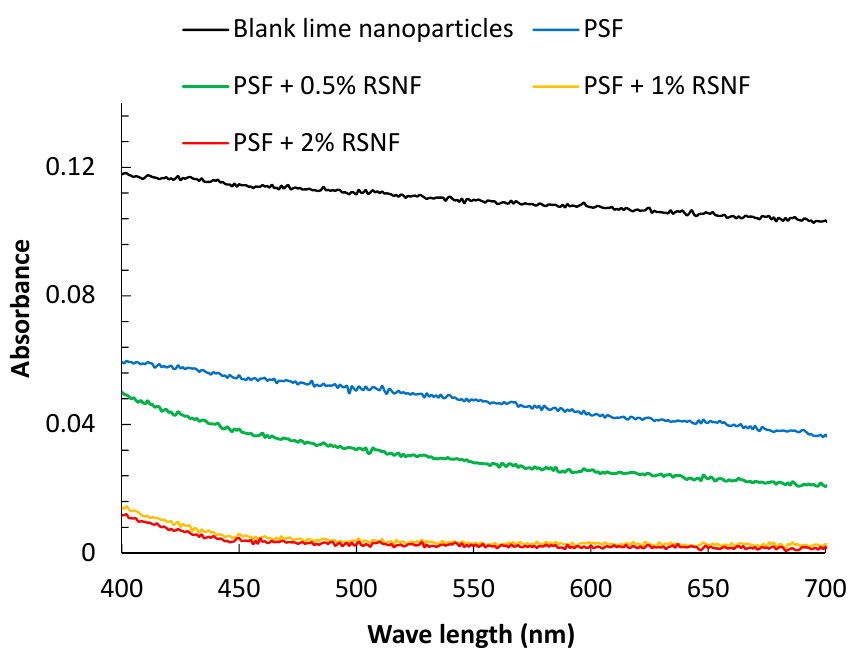
Figure 8. Absorbance spectra of lime nanoparticles suspension and filtrate produced after passing the suspension through the different PSF membranes.